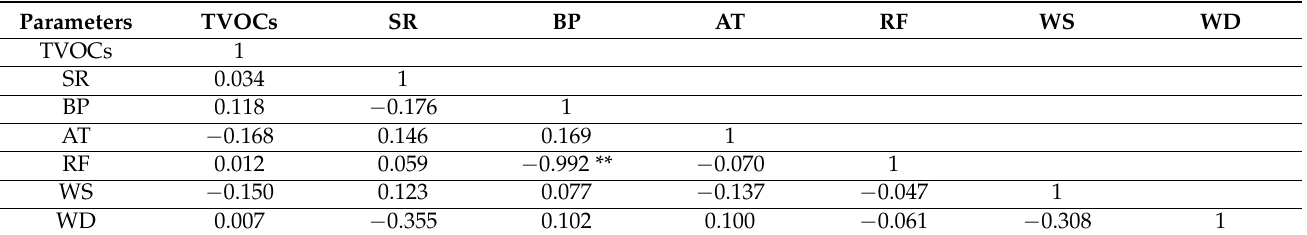
Table 5. The correlation coefficient between TVOCs and meteorological parameters for the year